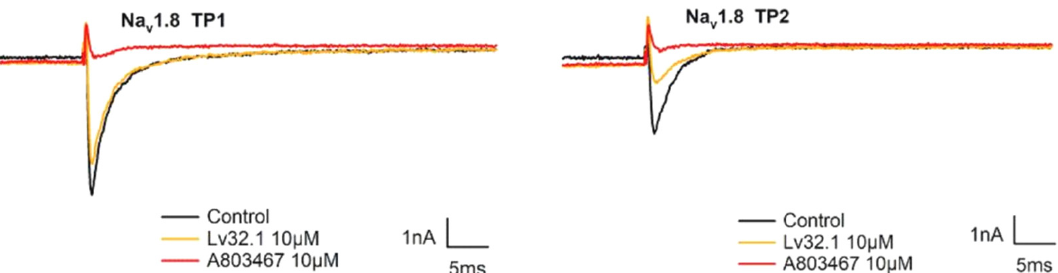
Figure 10. Traces of current inhibition on Na v 1.8 channel by Lv32.1.